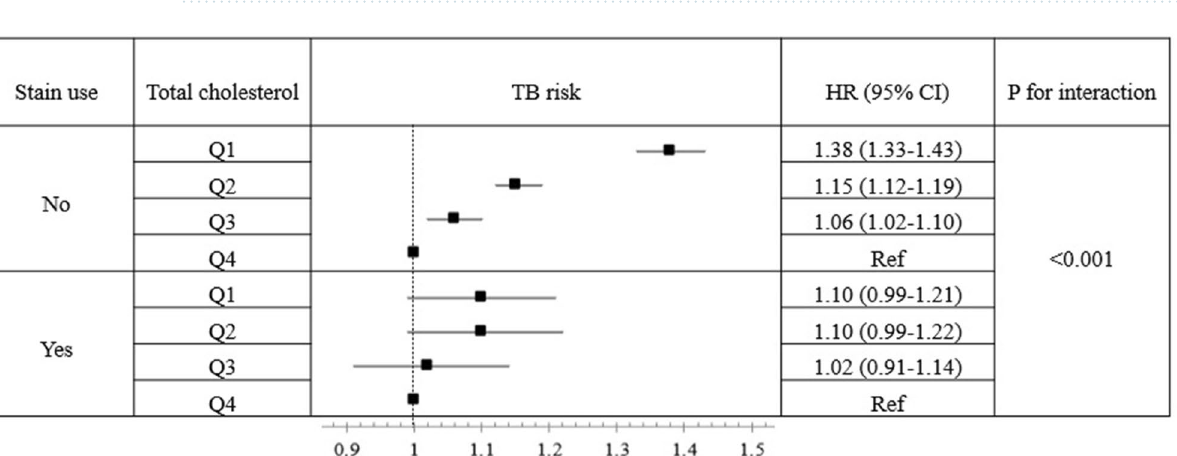
Table 2. TB risk by quartile of total cholesterol level. Data are presented as numbers and ratios (95% CI), as appropriate. Model 1 is adjusted for age, sex, smoking status, drinking habits, physical activity, BMI, diabetes mellitus, asthma or COPD, and GFR. Model 2 is adjusted for age, sex, smoking status, drinking habits, physical activity, BMI, diabetes mellitus, asthma or COPD, GRF, and statin use. TC total cholesterol, PY person-years, IR incidence rate, HR hazard ratio, CI confidence interval, BMI body mass index, Q1 the lowest quartile, Q4 the highest quartile BMI body mass index COPD chronic obstructive pulmonary disease, GFR glomerular filtration rate.